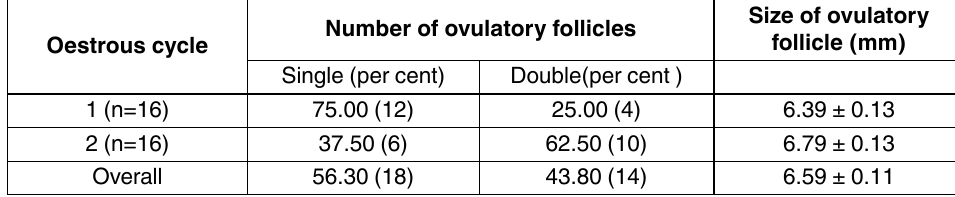
table 5 . Number and mean diameter of ovulatory follicles in Malabari doelings Oestrous